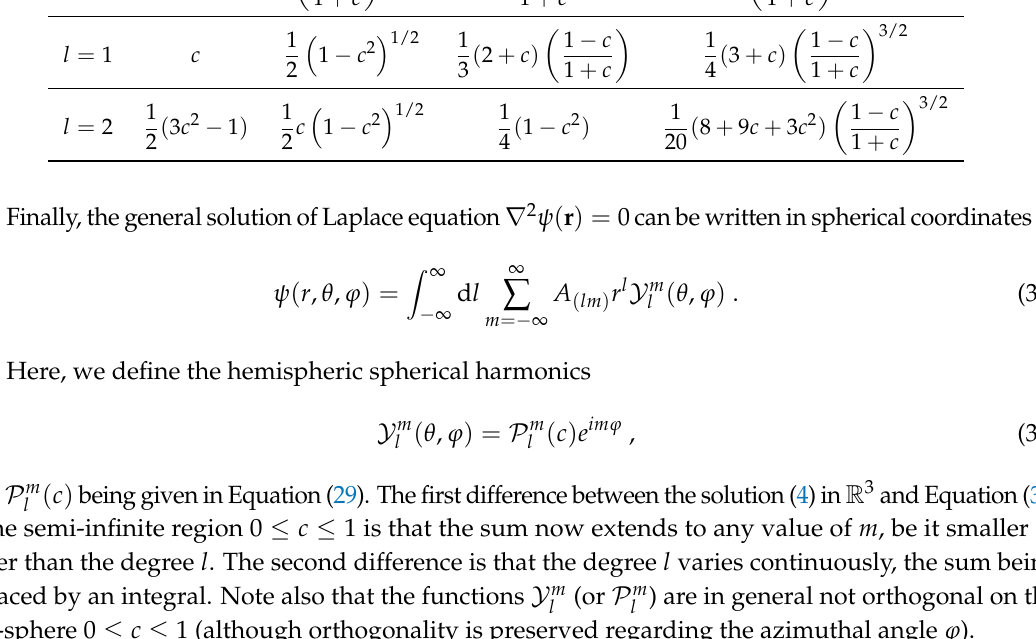
Table 1. Expressions of the first hemispheric Legendre functions P m m =